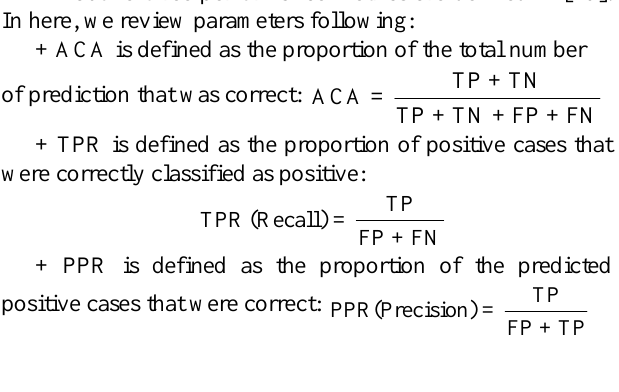
Table 2: The results of the classification of objects by SVM classifier for datasets